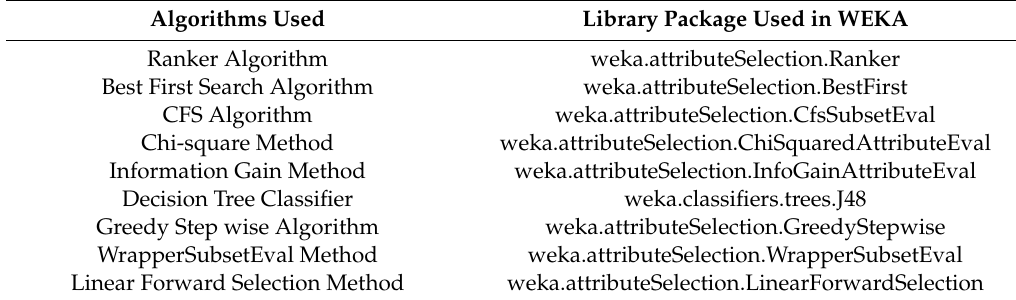
Table 7. Algorithms and their packages in WEKA